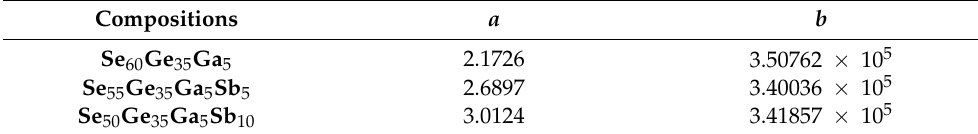
Figure 5. The refractive index’s spectral distribution along with the wavelength for studied films. Inset: The Cauchy equation fitting for the as-deposited films. Table 2. The constant values of a and b according to Cauchy-relation for the studied